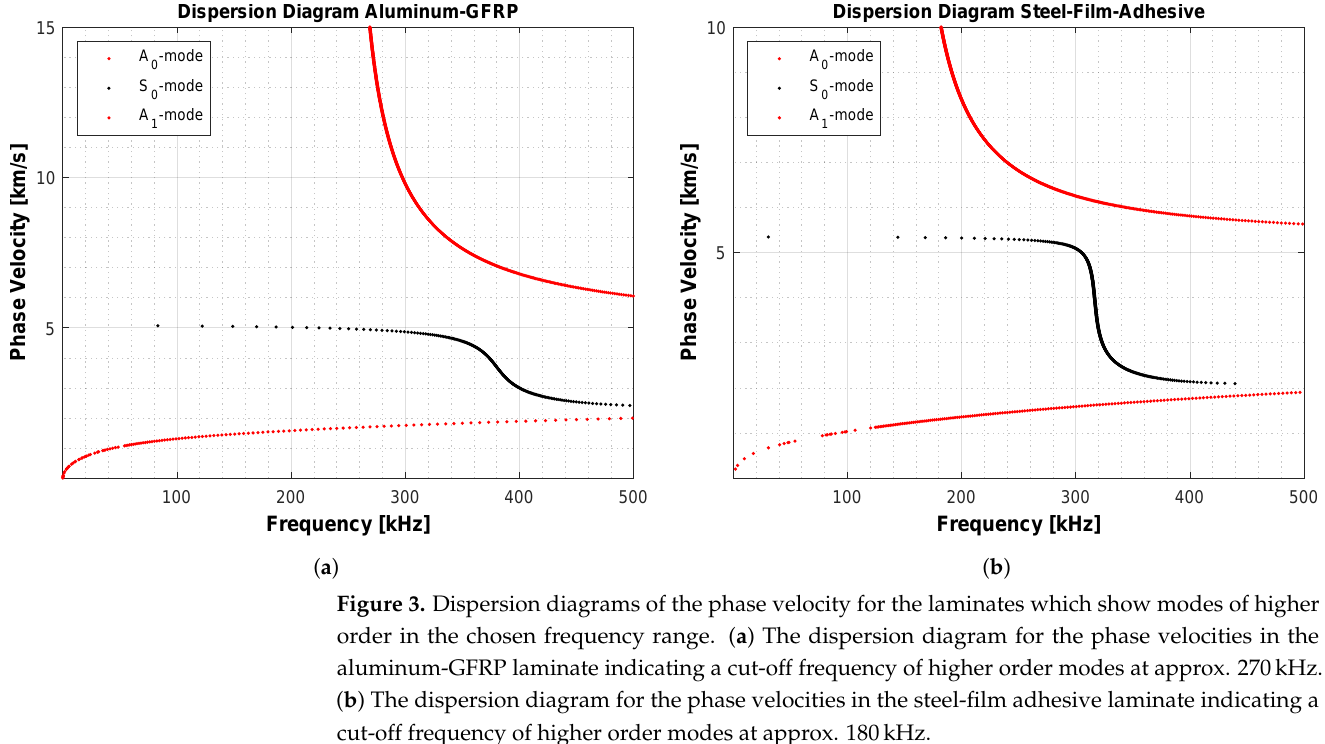
Figure 3. Dispersion diagrams of the phase velocity for the laminates which show modes of higher order in the chosen frequency range. ( a ) The dispersion diagram for the phase velocities in the aluminum-GFRP laminate indicating a cut-off frequency of higher order modes at approx. 270kHz. ( b ) The dispersion diagram for the phase velocities in the steel-film adhesive laminate indicating a cut-off frequency of higher order modes at approx.